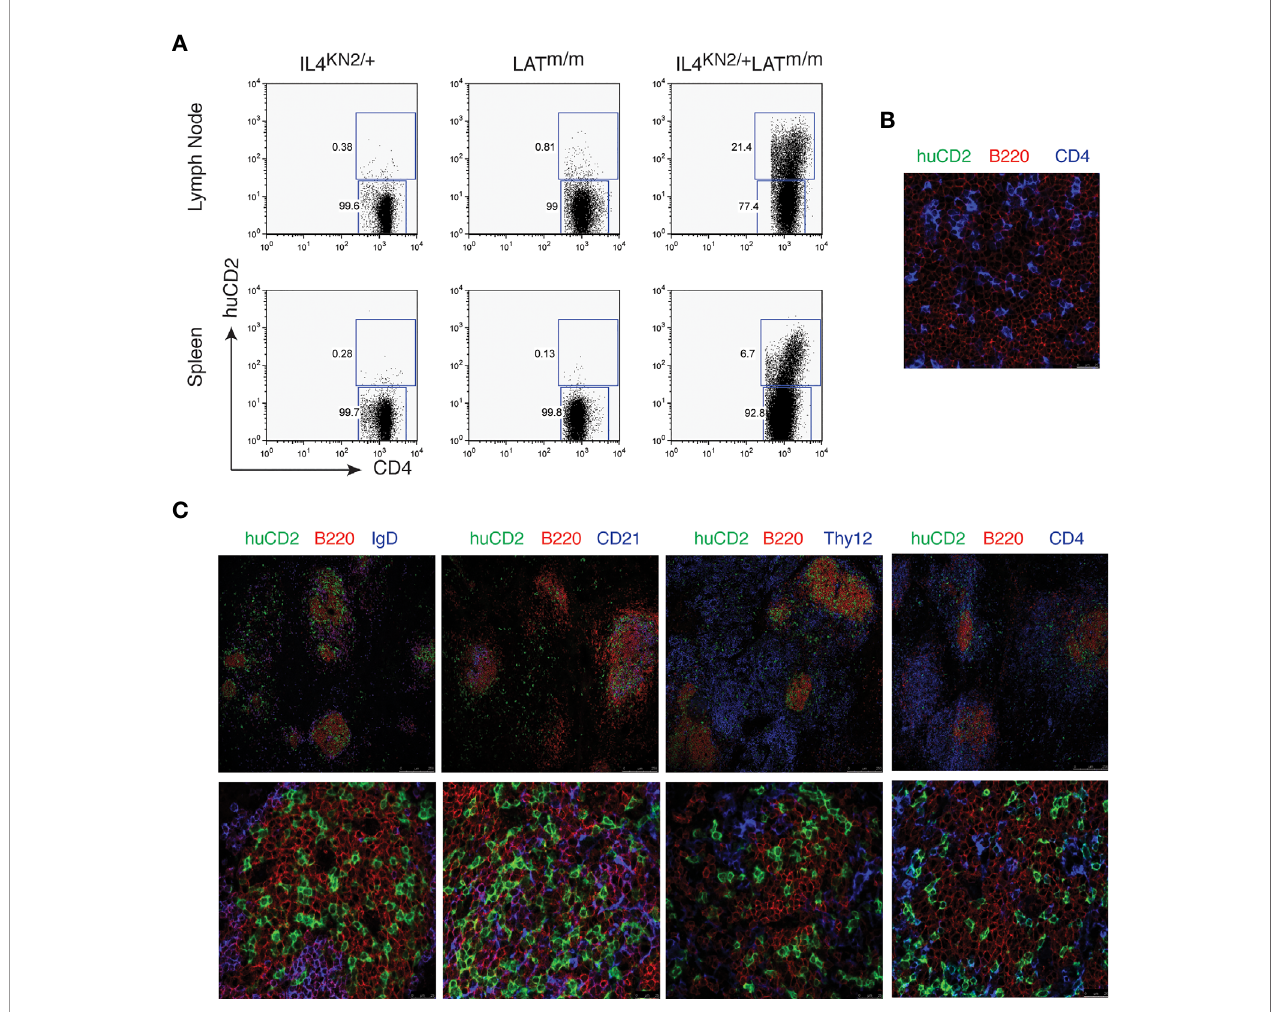
FIGURE 1 | IL4-producing T cells in LATY136F mice. (A) IL4 production, indicated by human CD2 expression, in CD4 + T cells from spleens and inguinal lymph nodes from 6-8wk-old IL4 KN2/+ , LAT m/m , and IL4 KN2/+ LAT m/m mice. (B, C) 5 m m spleen sections from 3-month-old LAT m/m (B) and IL4 KN2/+ LAT m/m (C) mice were stained with anti-mouse B220-PE (red), huCD2-biotin, ampli fi ed using fl uorescein-tyramide (green), and biotinylated anti-CD4, IgD, CD21, and Thy1.2 antibodies followed by streptavidin Alexa Fluor 647 (blue). Imaging was performed using confocal microscopy at 20x (top) and 70x (bottom) magni fi cation. Data are representative of 3 individual